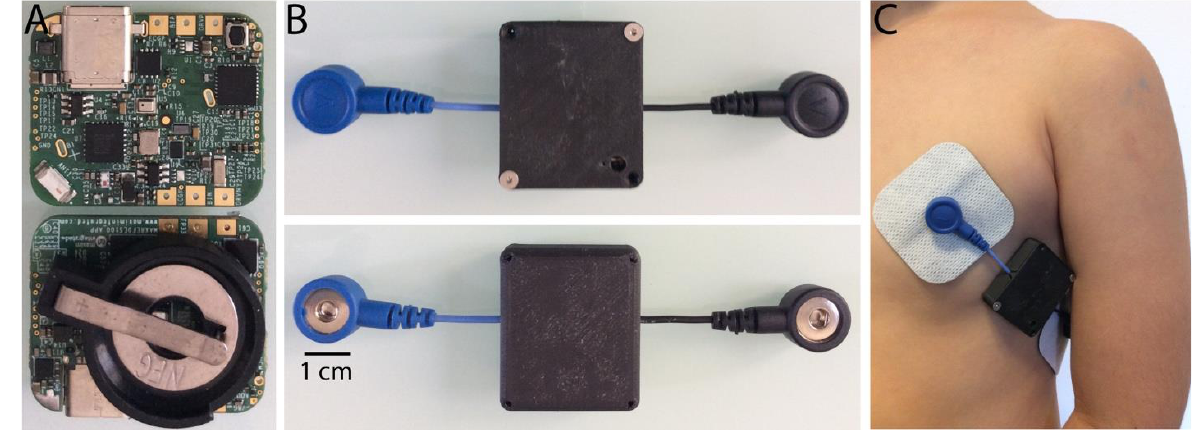
Figure 2. COR sensor. ( A ) Top view of the board showing the ECG components and BLE set chip for wireless communication. The bottom view shows the battery holder for a CR2030 coin cell. ( B ) The end-to-end length includes ground (black), main lead (blue), and the 3D-printed black plastic encase that protects the primary circuit. ( C ) An example of leads positioning on a 4-year-old